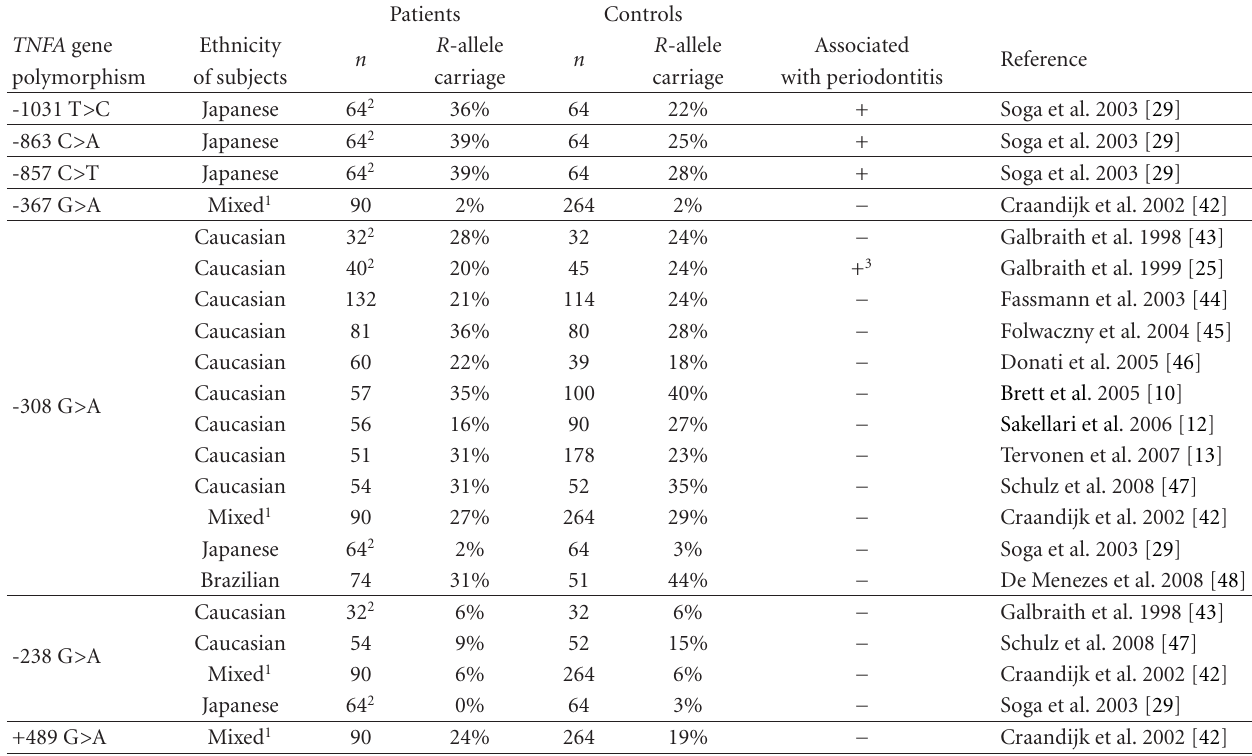
Table 5: TNFA gene polymorphisms and carriage rate of the Rare ( R )-allele in case-control studies and association with susceptibility to chronic